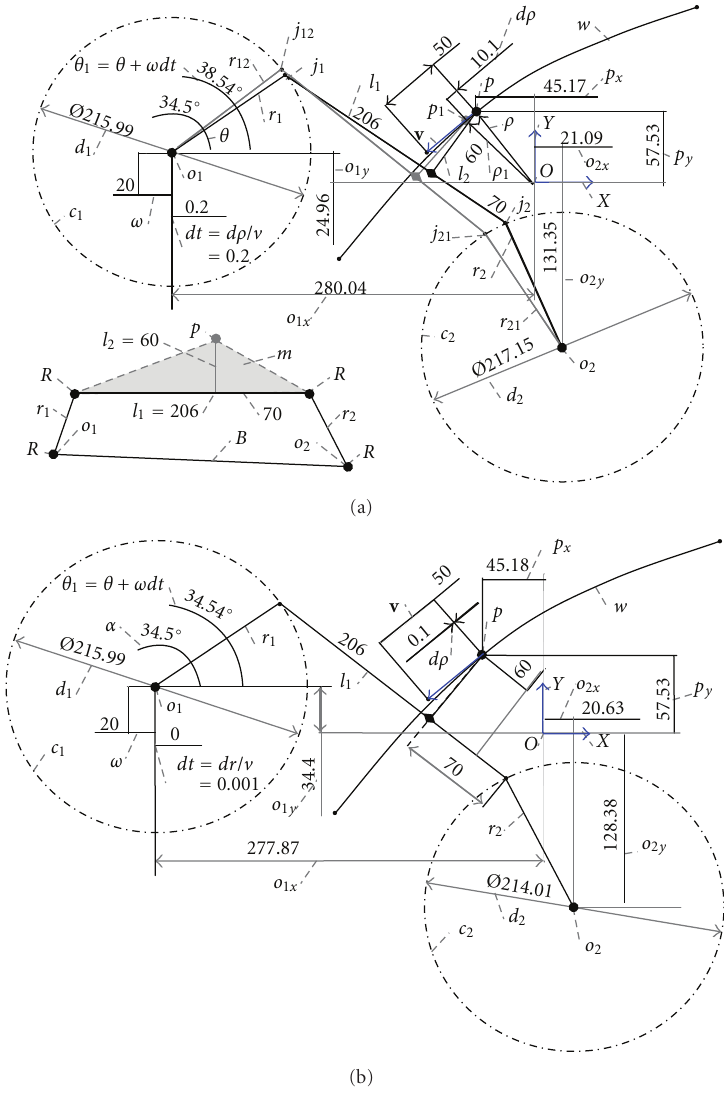
Figure 2: A planar four-bar velocity simulation mechanism versus dρ = 10 . 1 and dρ = 0 .